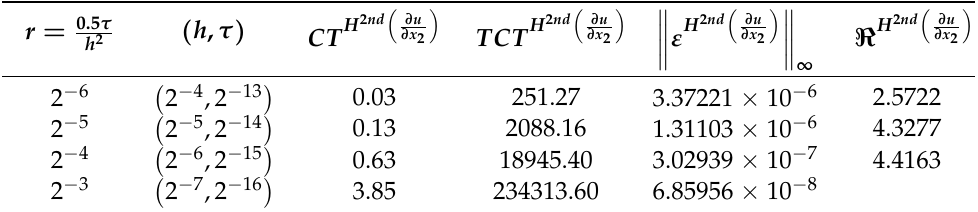
Table 6. Computational time, maximum norm of the errors, and the order of convergence of z h , τ to the exact derivative z = ∂ u when (174) and (175) are used and r = 0.5 τ ∂ x 2 r = 0.5 τ h 2